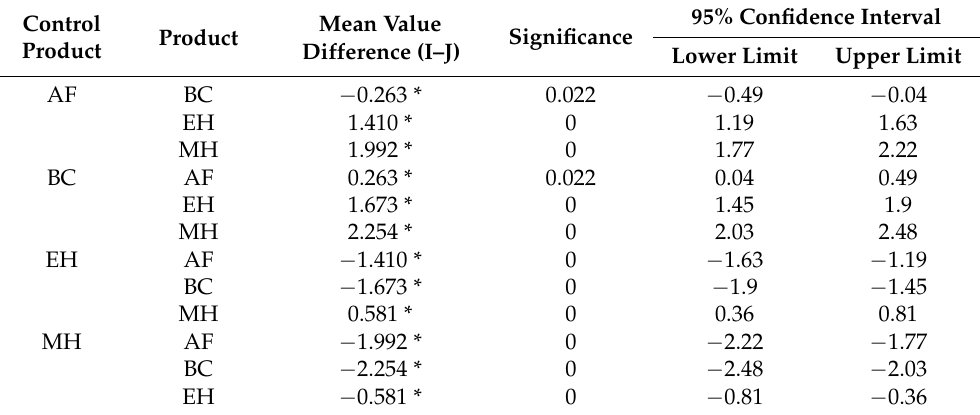
* Indicates that the significance level of the mean difference is 0.05.